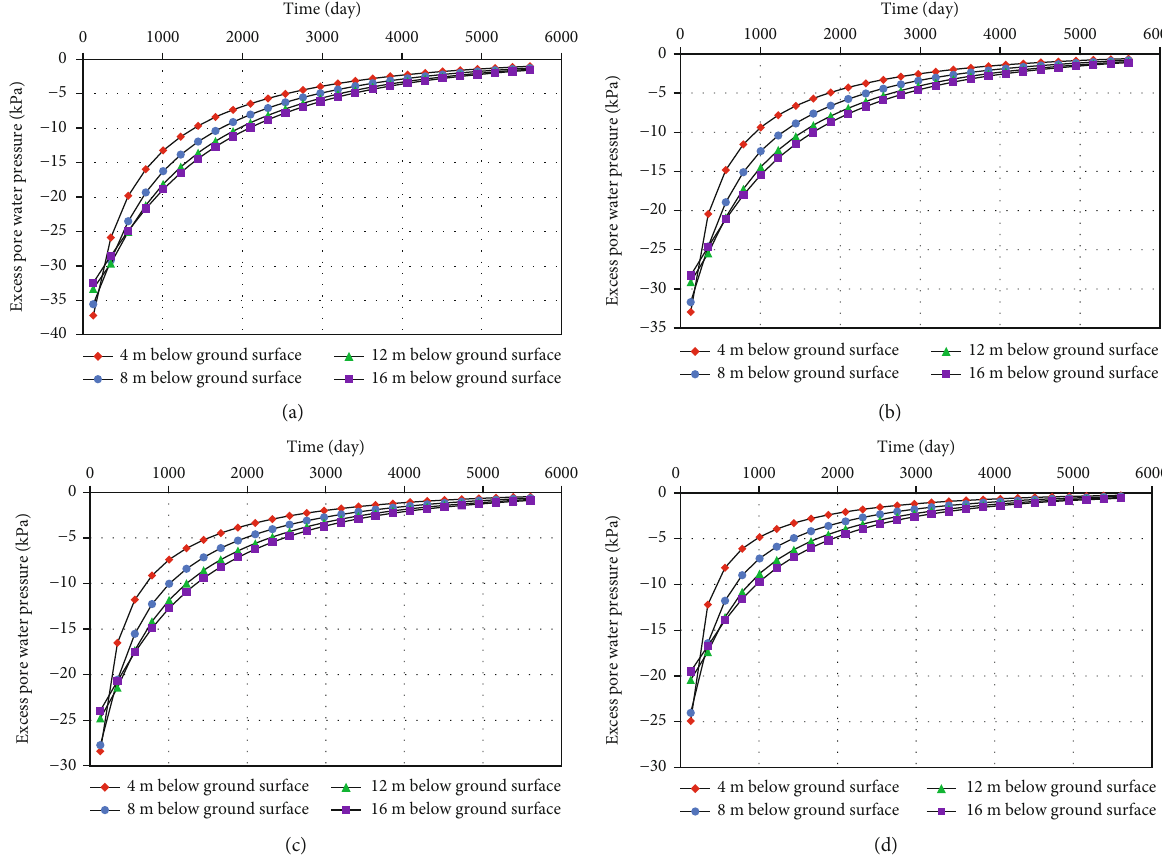
Figure 14: Excess pore water pressure-time curve in soft soil under embankment center with the replacement thicknesses of (a) 1.5 m, (b) 2.0m, (c) 2.5m, and (d)